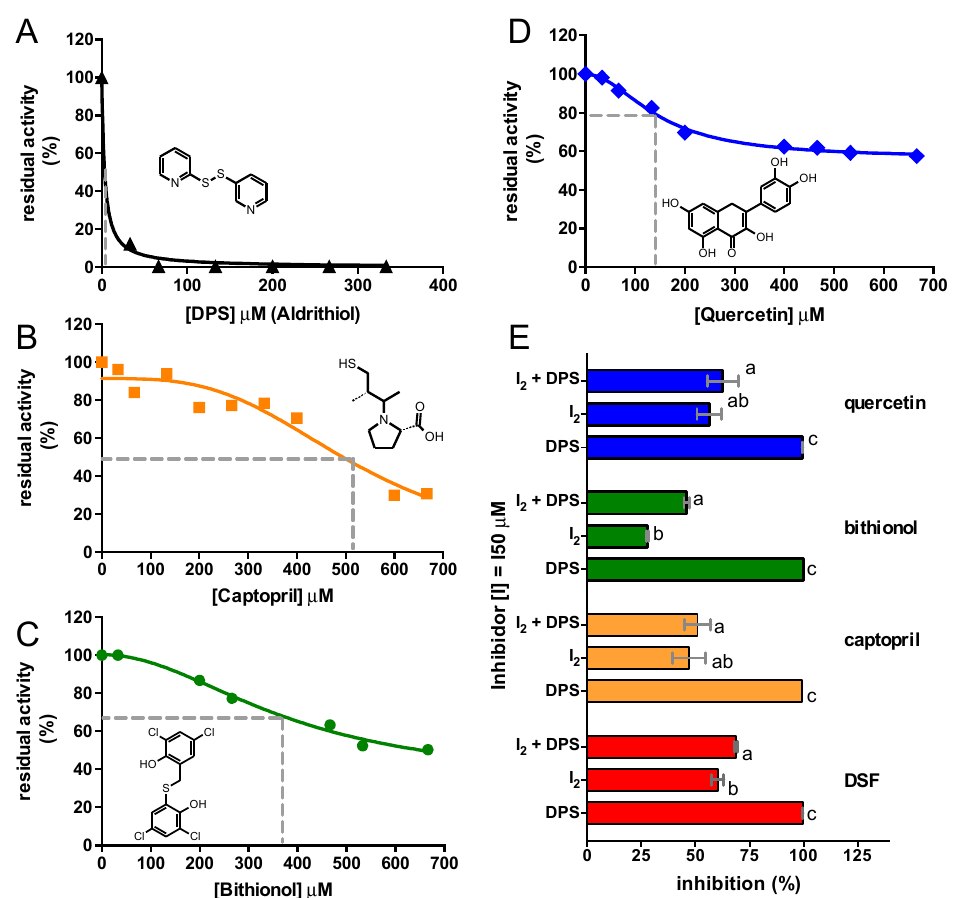
Figure 3. Inhibition of CVU with a specific thiol-reagent and other reactive drugs. ( A ) Inhibition kinetics of CVU by DPS; ( B ) Captopril; ( C ) Bithionol and ( D ) Quercetin. The solid lines in A and B show the best curve fitting to Equation (3), and the solid lines in C and D show the best curve fitting to Equation (4); the latter corresponds to a partial inhibition equation, where the initial and equilibrium residual activity (span) is considered for the IC 50 calculation. The chemical structures of inhibitors are depicted in the corresponding graph and were drawn using ACD/ChemSketch ® . The inhibition curve produced by DSF is depicted in Figure 2C. The dashed grey line shows the concentration of inhibitor at 50% of total inhibition ( E ) Percentage of inhibition produced by drugs (I 2 : captopril, bithionol and quercetin) and DPS at the concentration equal to the IC 50 value. In I 2 + DPS, CVU was incubated with a given drug for 1 h and then DPS was added and immediately the residual activity was measured, showing that I 2 protects CVU from full DPS inhibition. The experiment was reproduced three times, and mean and standard error are plotted. A one-way ANOVA was performed to find significant differences between treatments. The different characters depicted on bars indicate significant differences at p < 0.05. Plots were prepared using Graph Pad Prism 5 ® .